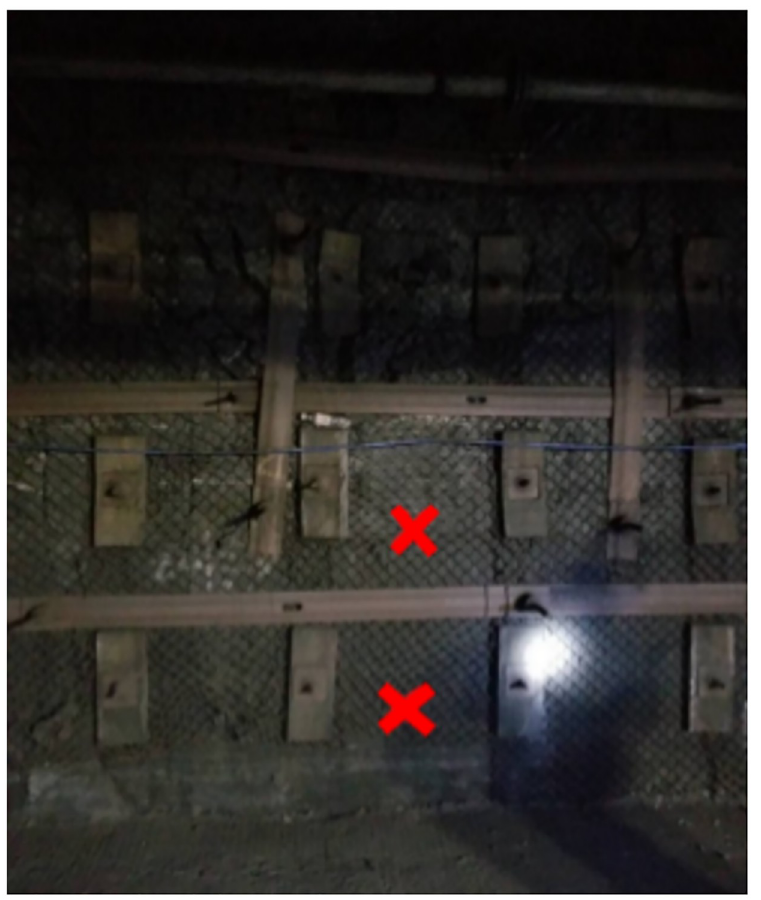
Fig 19. Bolt arrangement position of negative